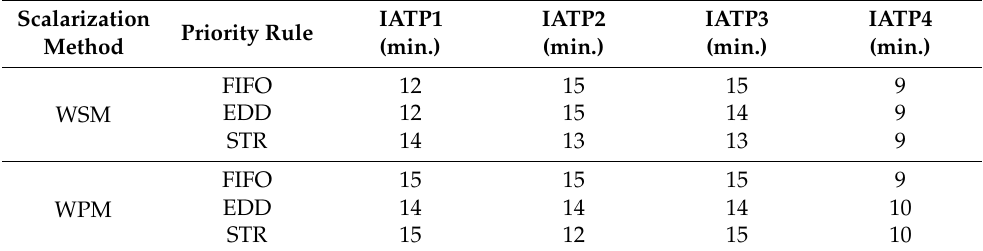
Table 8. Design input values of the inter-arrival times for parts P1—P4 in the design space corre- sponding to optimal production outputs (shown in Table 7) in objective space. Scalarization